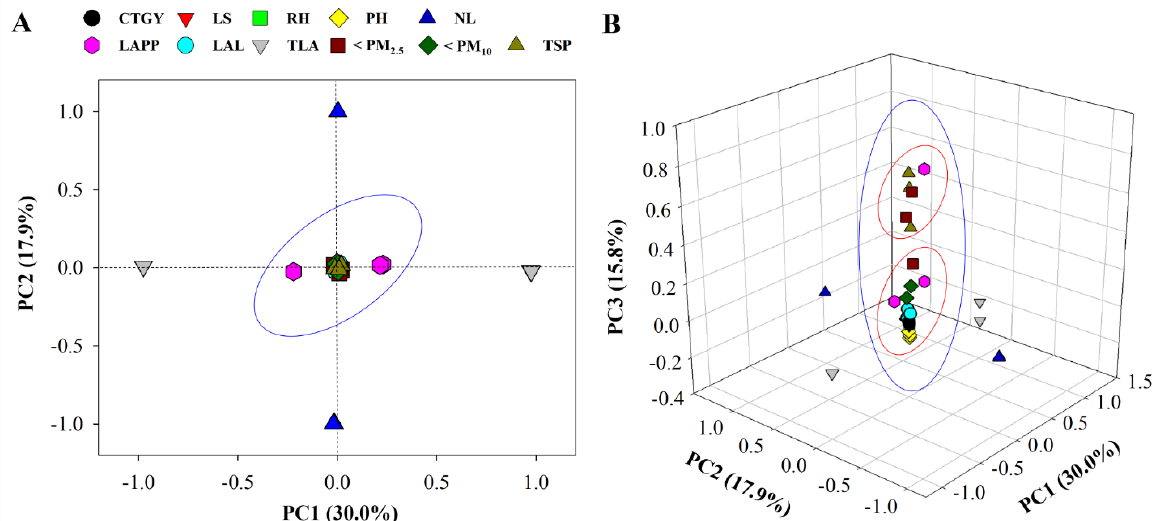
Figure 3. Principal component analysis (PCA) of various factors and particulate matter (PM) reduction by plants including ( A ) 3D plot of PCA and ( B ) 2D plot of PCA. Black represents categories of plants (CTGY), red represents leaf shape (LS), green represents the time to achieve ≥90 % relative humidity (RH) in the acrylic chamber, yellow represents plant height (PH), blue represents the number of leaves (NL), pink represents the leaf area per plant (LAPP), see blue represents leaf area (LAL), gray represents the leaf area of total plants in chamber (TLA), brown represents the mass concentration of reduced PM 2 . 5 after 8 h (<PM 2 . 5 ), dark green represents the mass concentration of reduced PM 10 after 8 h (<PM 10 ), and deep yellow represents the mass concentration of reduced TSP after 8 h (TSP).